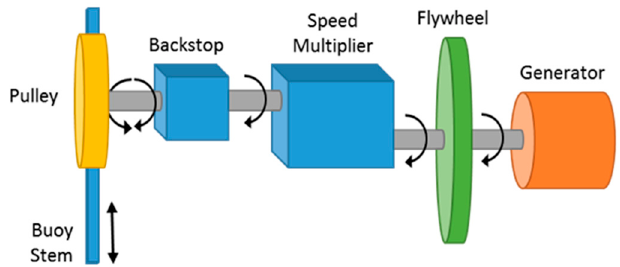
Figure 20. Components of the COPPE nearshore WEC.